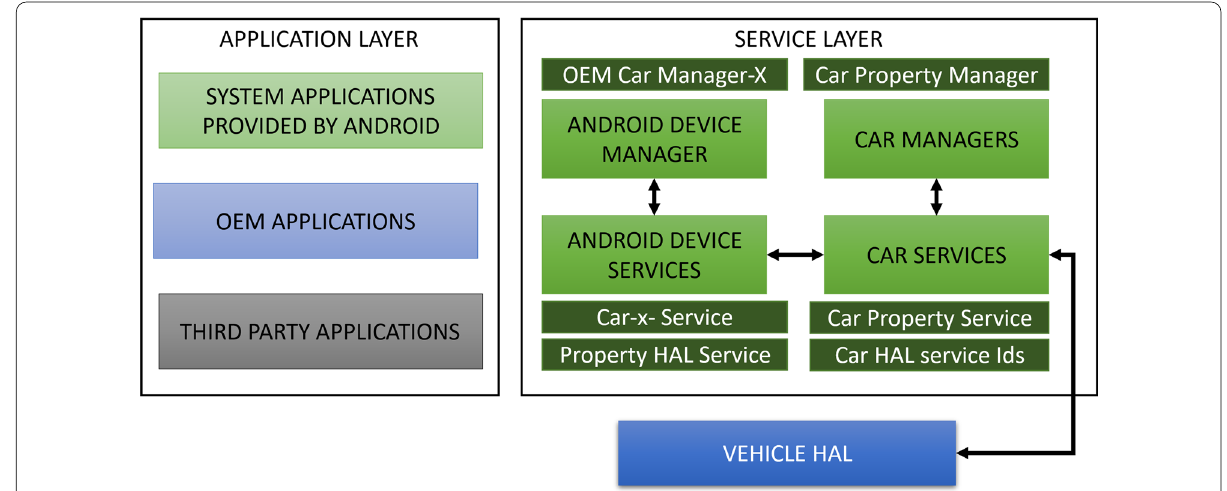
Fig. 1 Android automotive architecture depicting automotive services and system applications